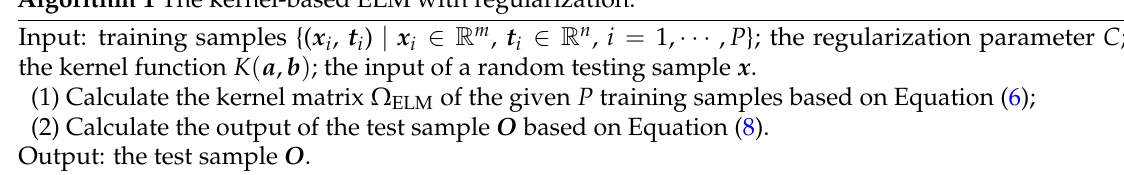
Algorithm 1 The kernel-based ELM with